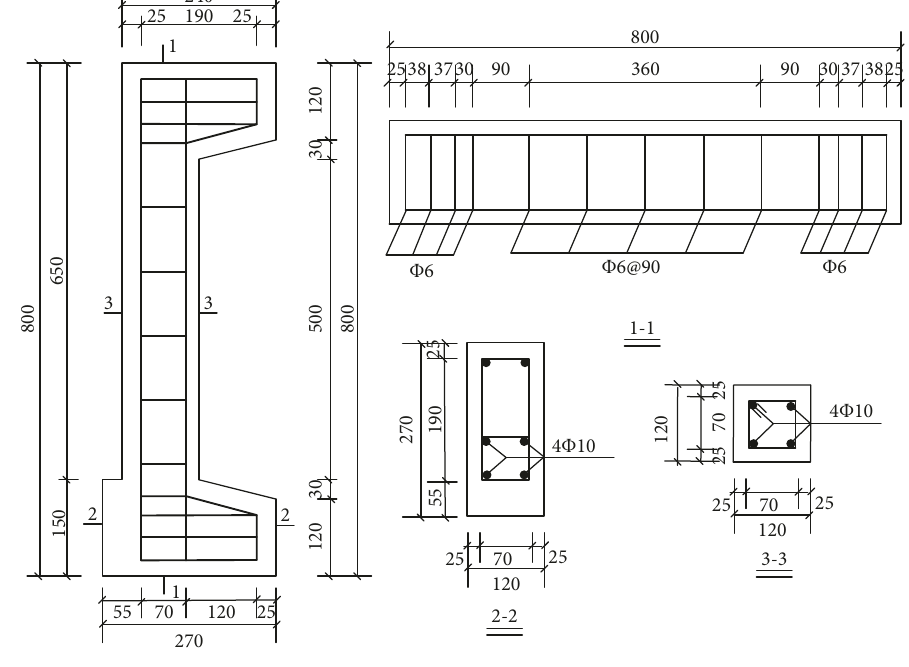
Figure 1: Details of reinforced concrete columns (mm). Table 1: Testing conditions of reinforced air-entrained concrete